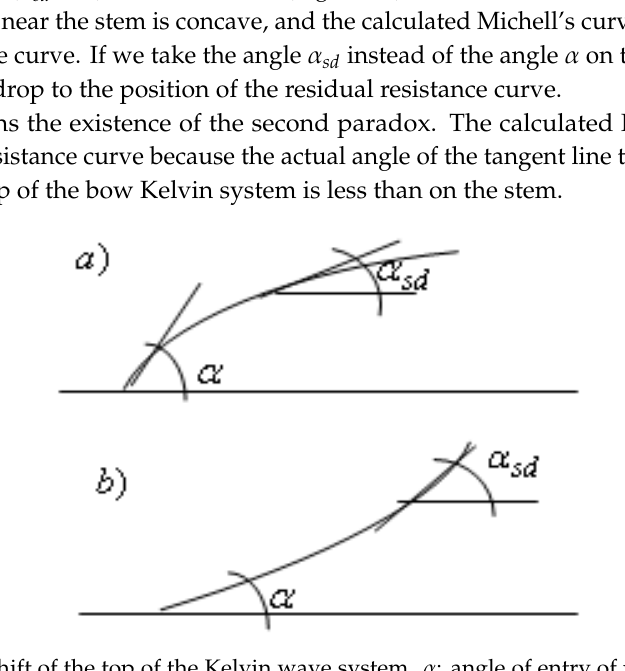
α : angle of entry of main waterline,